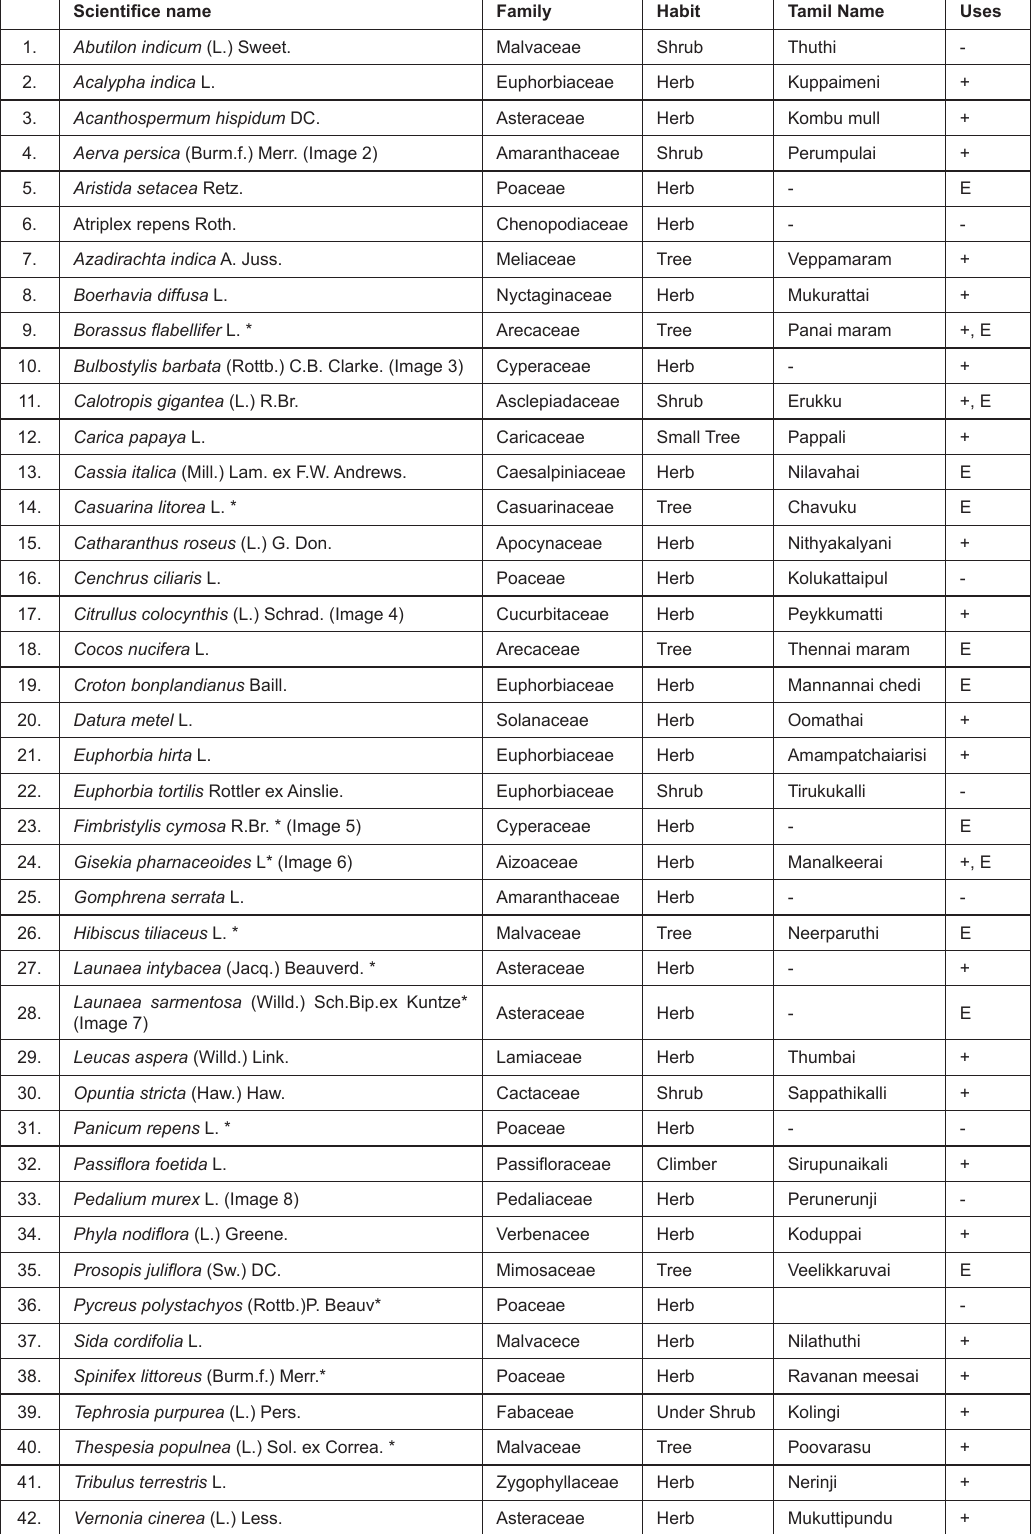
E - Economic values; + - Medicinal values; * - Typical CSD